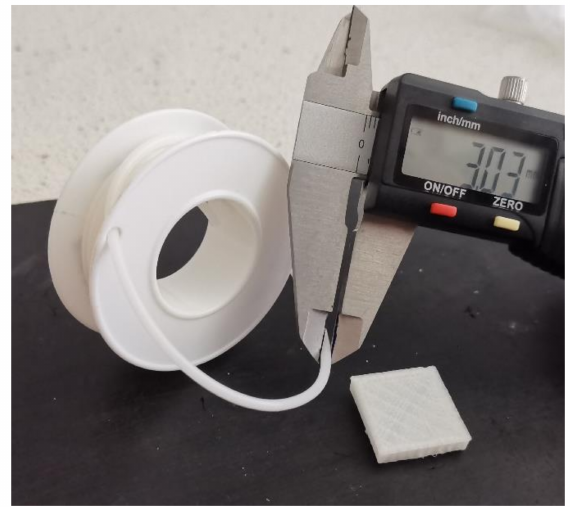
Figure 11. Photography of the produced COMP-7,5PLA filament and printed